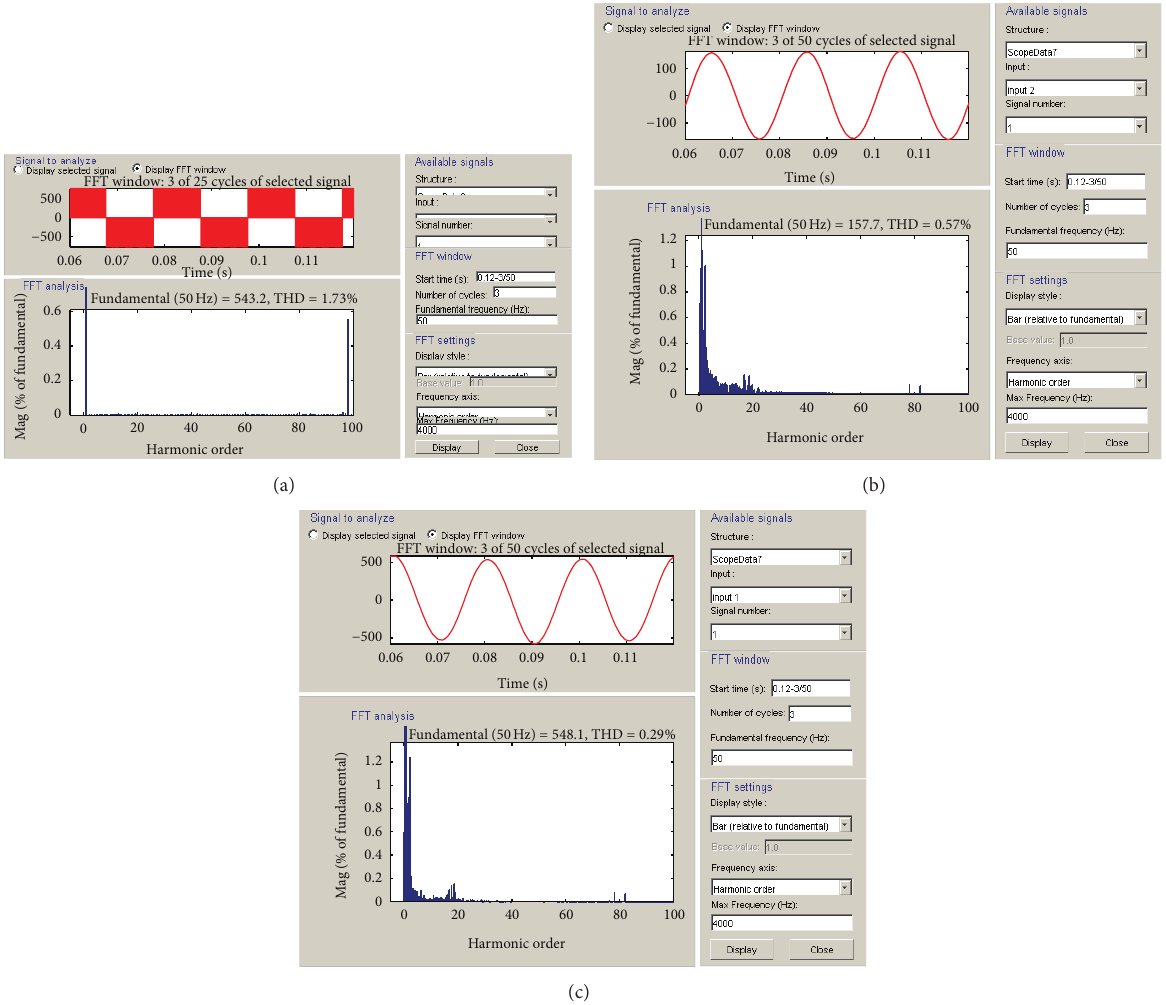
FFT window: 3 of 50 cycles of selected signal